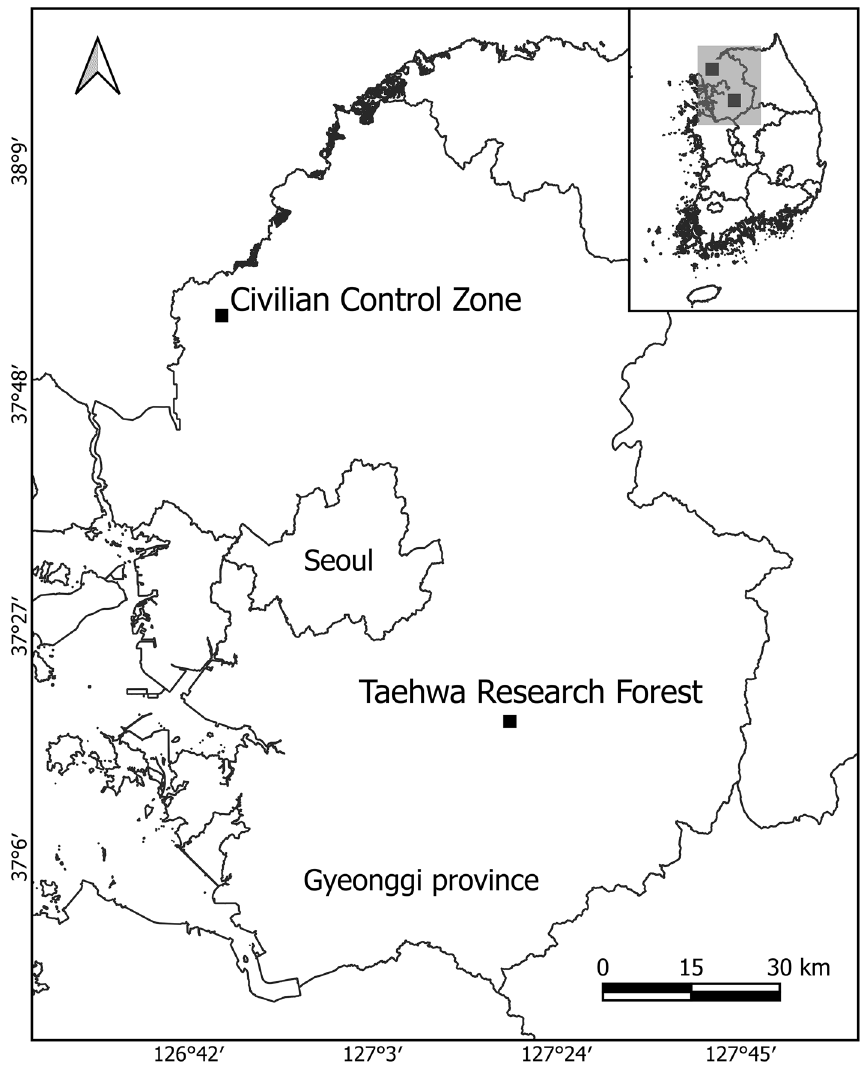
Figure 1. Sampling sites of the Korean water deer feces in Gyeonggi Province, South Korea. The Civilian Control Zone (CCZ) as a representative site of lowland habitats and the Taehwa Research Forest (TRF) as a representative site of forest